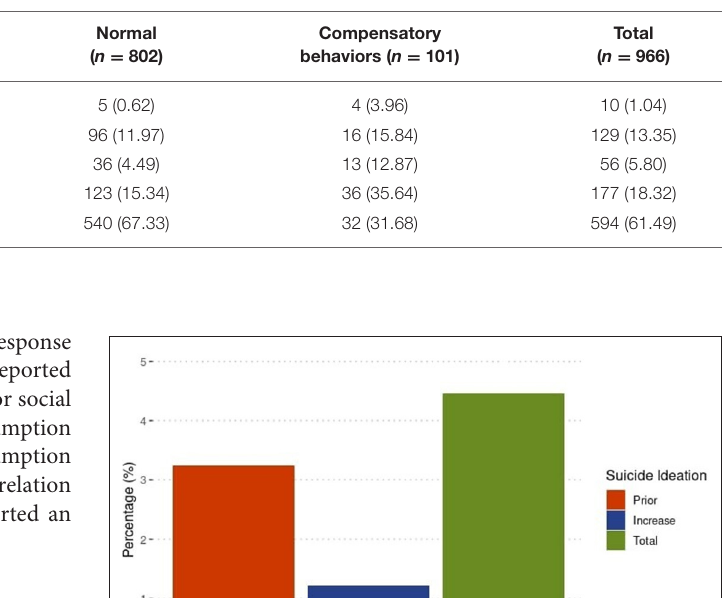
TABLE 2 | Modification of eating habits.